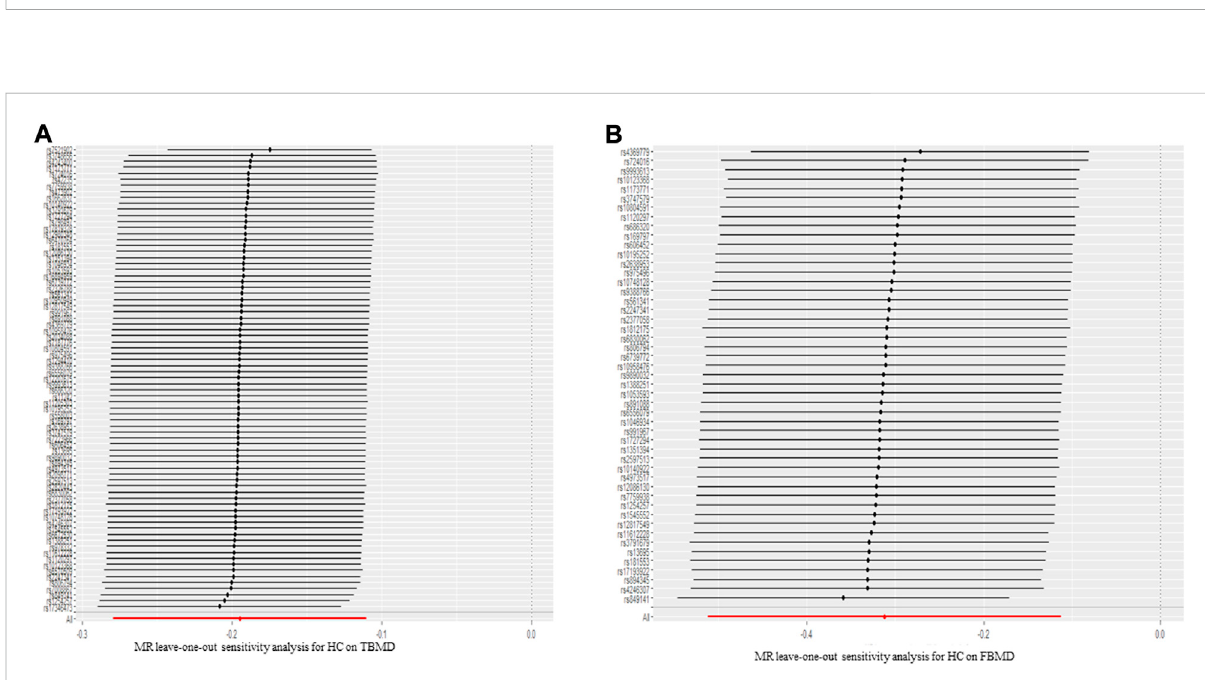
Theleave-one-outsensitivityanalysisforhipcircumferenceontotalbodymineraldensity (A) andfemoralbodymineraldensity (B) .TBMD:total bone mineral density; MR: Mendelian randomization; FBMD: femoral body mineral